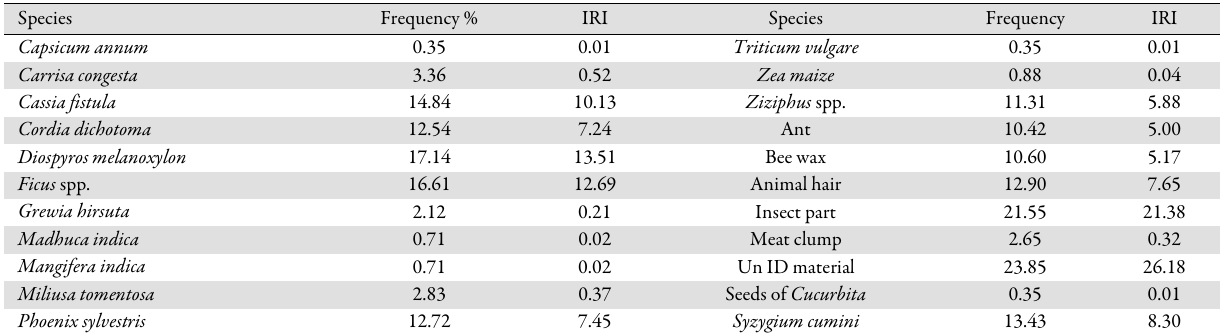
Table 1. Importance of dietary species in the diet of Sloth bear ( Melursus ursinus ) based on the Index of Relative Importance (IRI) Species